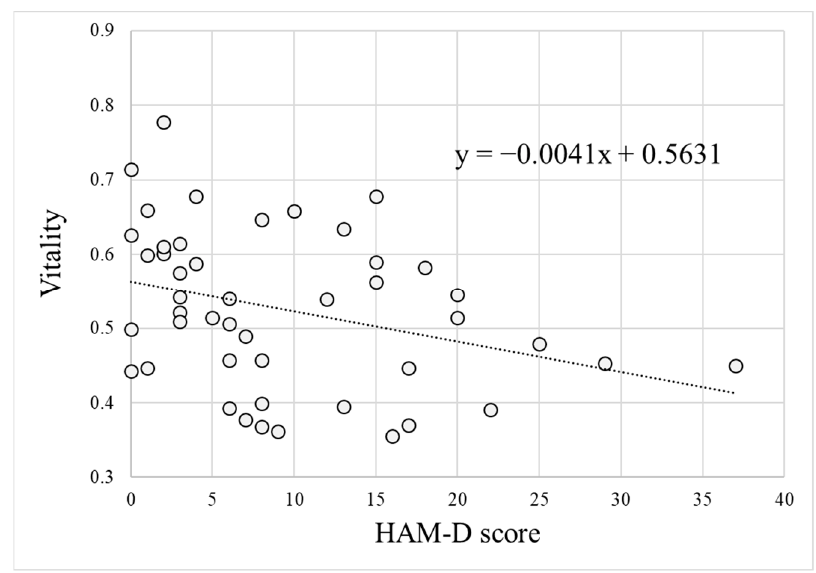
Figure 3. Relationship between Hamilton Rating Scale for Depression (HAM-D) score and vitality in the data of patient group for algorithm verification. The figure also shows the regression line for the data (y = − 0.0041x + 0.5361).